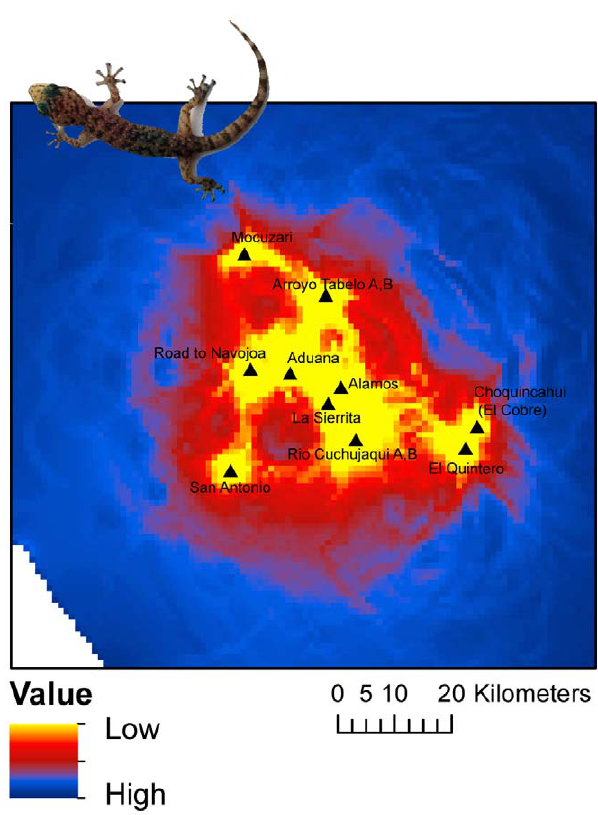
Figure 5. Results from CIRCUITSCAPE depicting cumulative resis- tance between populations of Phyllodactylustuberculosus based on the combined effect of Euclidean distance, slope and riparian connectivity. ‘Low’ in figure legend represents low levels of resistance whereas ‘High’ represents high levels of resistance.